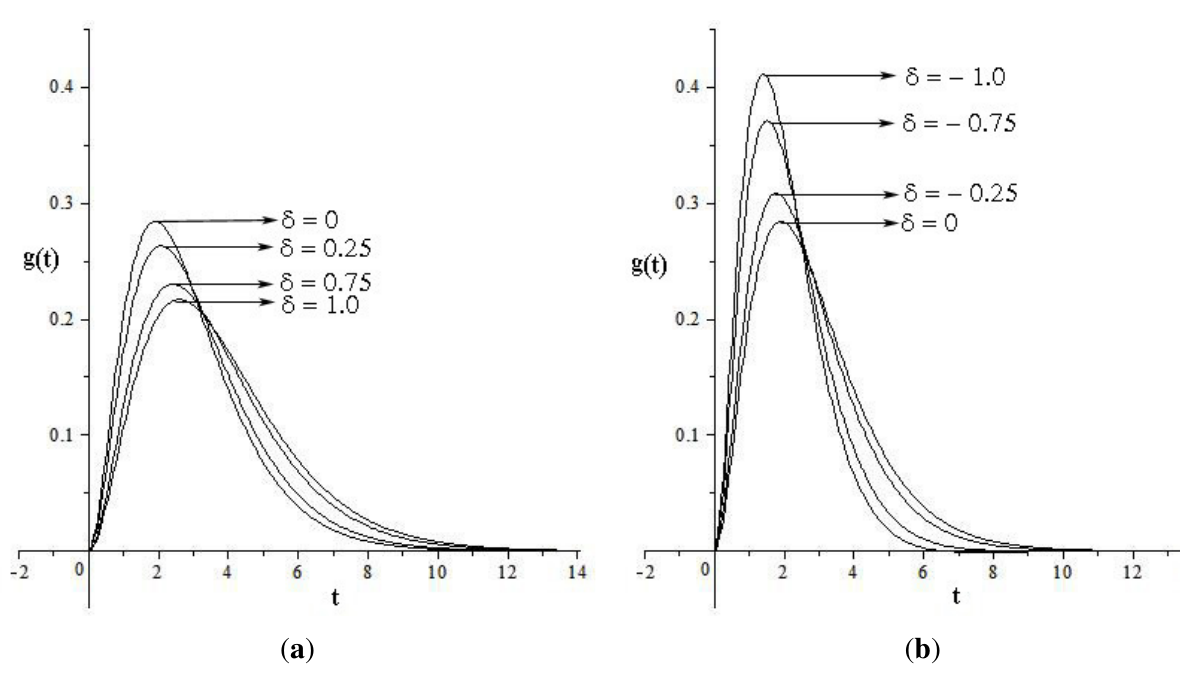
Figure 1. ( a ) Gamma Bessel model for δ > 0 ; ( b ) gamma Bessel model for δ < 0